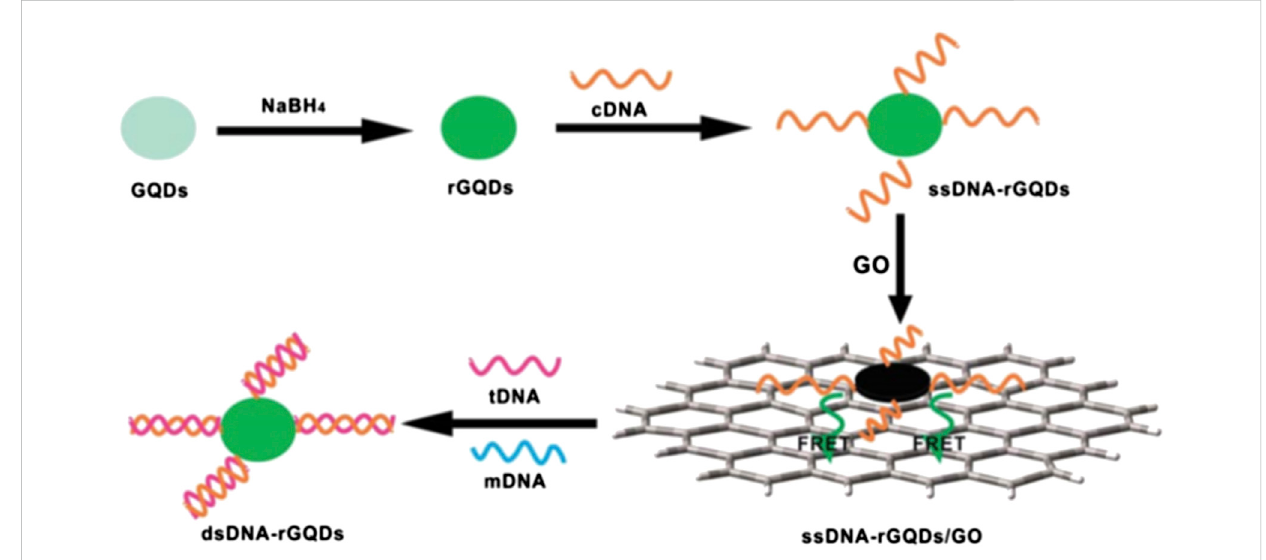
FIGURE 4 Schematic of a universal fi uorescence based sensor mechanism for the detection of DNA -FRET between GQDs and graphene oxide (GO) (Qian et al.,